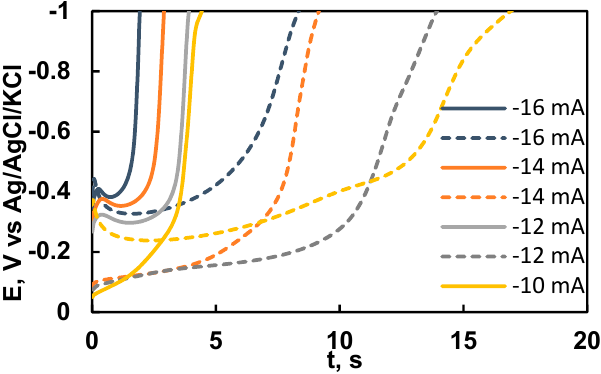
Figure 8. Chronopotentiograms on flat (continuous lines) and porous (dashed lines) electrodes at various current densities in 50 mM CuSO 4 and 0.45 M Na 2 SO 4 solution. All the densities have been calculated for the geometrical area of the substrate of 1 cm 2 .